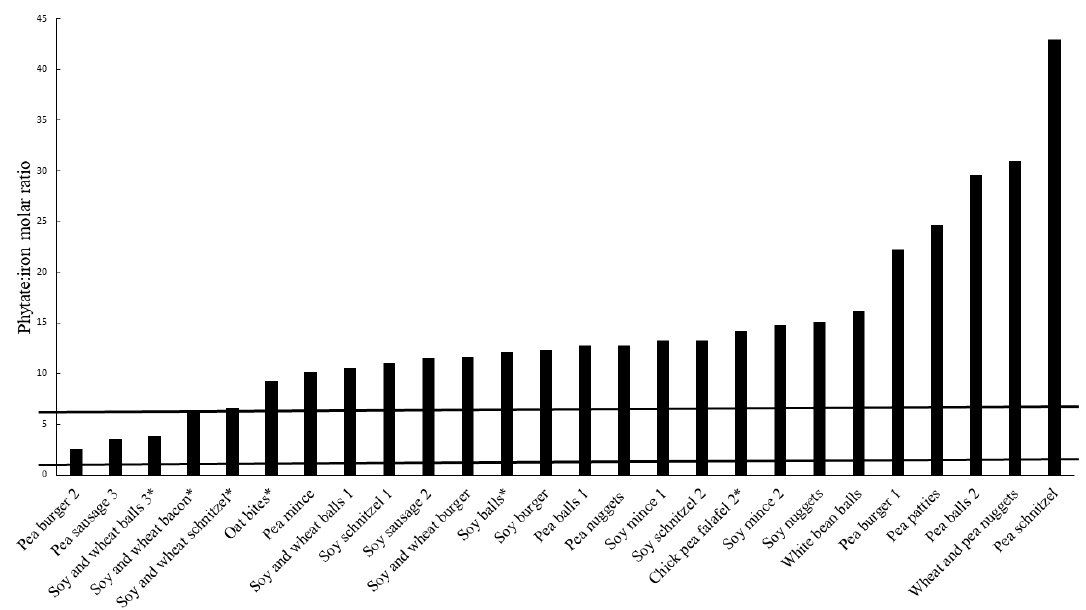
Figure 4. Molar ratio of phytate:iron in meat substitutes with an iron content ≥ 2.1 mg/100 g. The horizontal lines correspond to a phytate:iron molar ratio of 1 and 6 respectively: * product had a nutrition claim of iron.